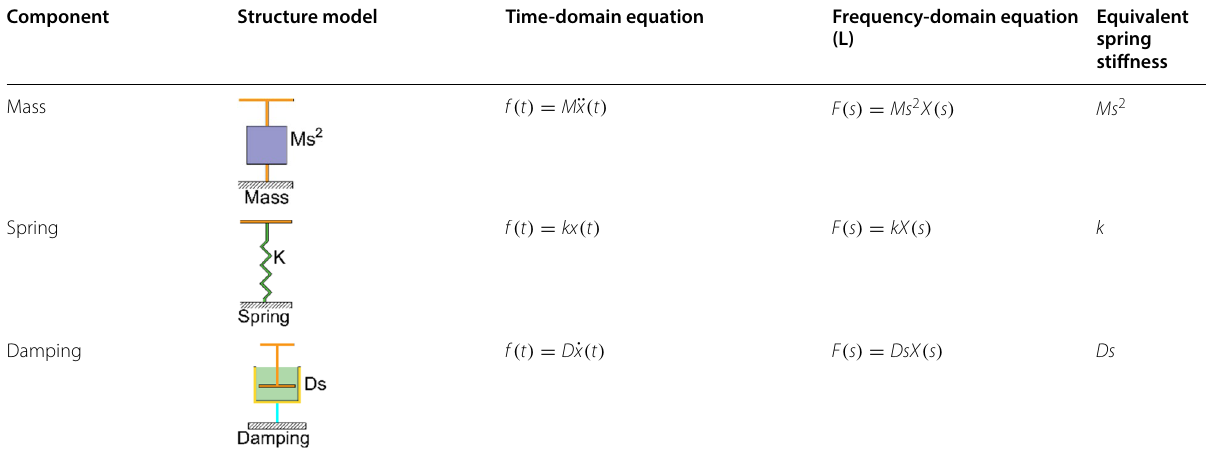
Table 1 Equivalent spring stiffness of the